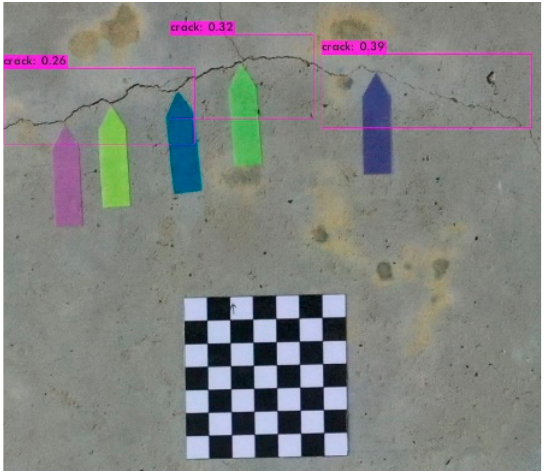
Figure 14. Crack identification outcome.